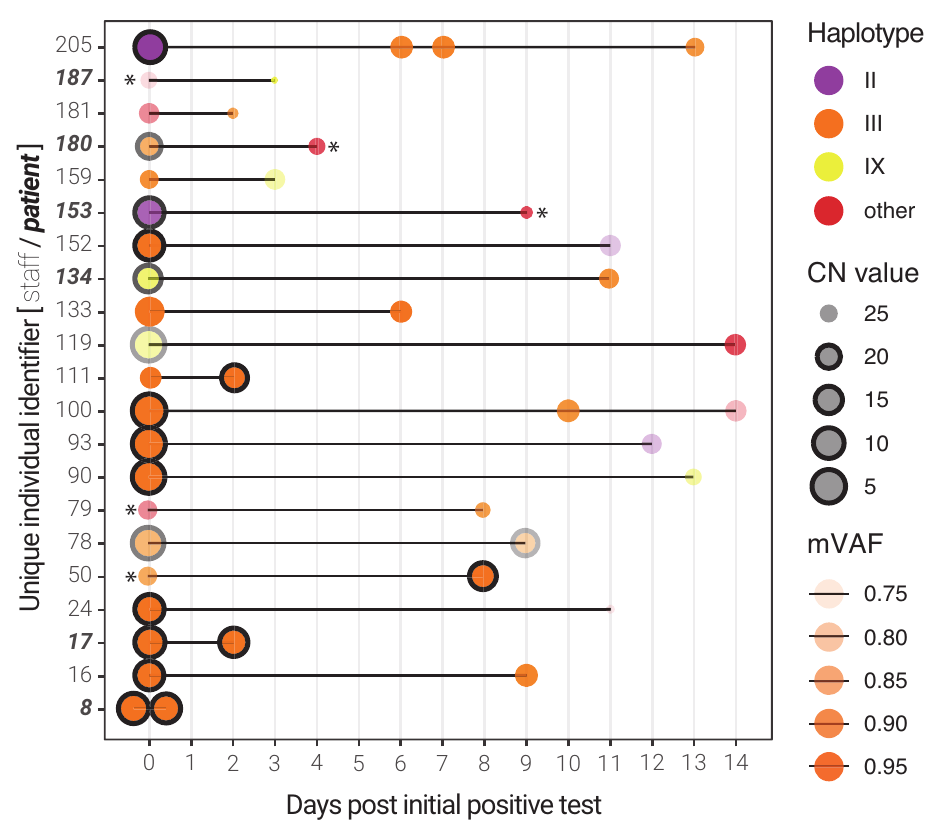
Fig 5. Longitudinal sequencing of SARS-CoV-2 positive subjects. Multiple samples for the same individual at different time points are linked by a black line. The size of the points represents the CN score at diagnosis (with black edges corresponding to scores � 20) and the opacity represents the mean variant allele frequency (mVAF). Individual 8 was sampled twice on the same day. Asterisks indicate consensus genomes with < 80% completeness.